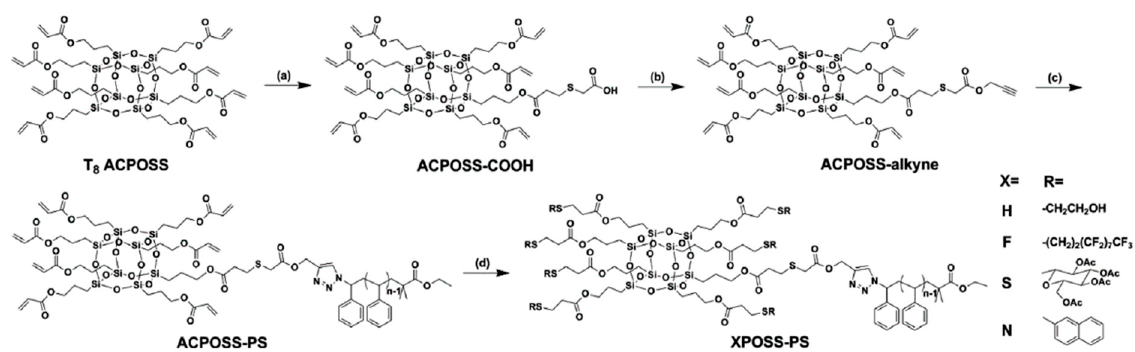
Figure 19. A synthetic pathway to giant surfactants using sequential “click” chemistry: ( a ) 2-mer-